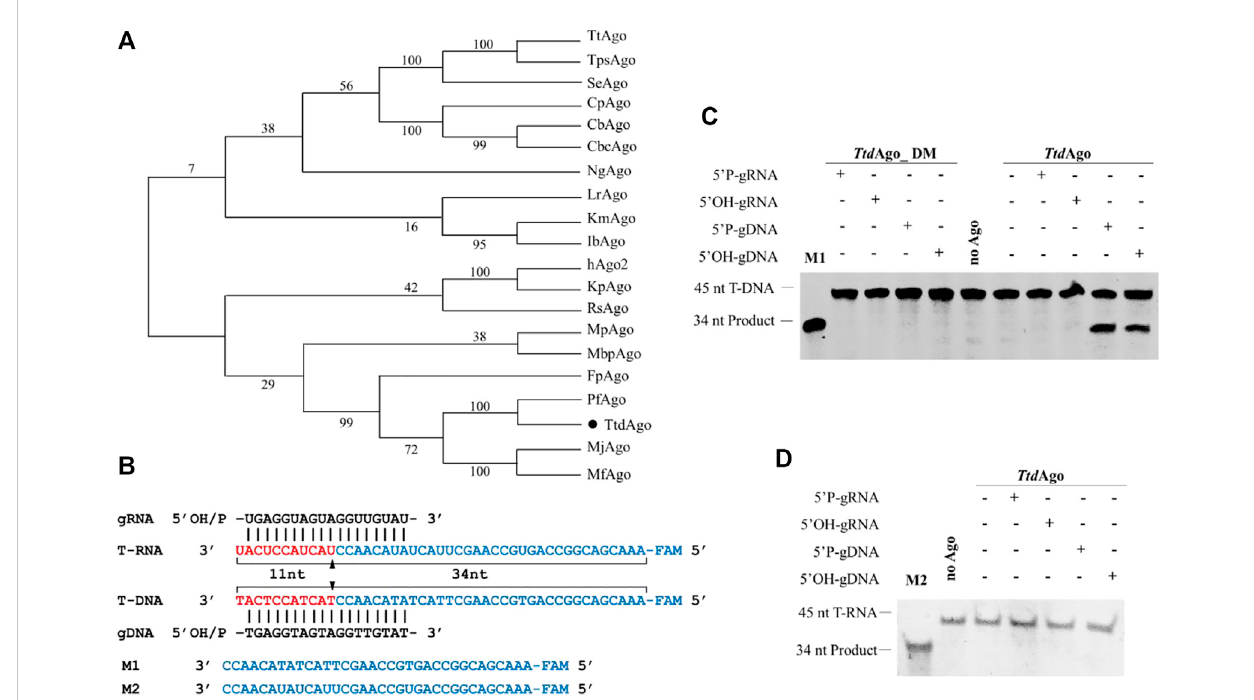
FIGURE 1 Phylogenetic tree analysis and single-stranded nucleic acid cleavage assays of Ttd Ago. (A) Maximum likelihood phylogenetic tree of characterized Agoproteins.Thenumbersatthenodesindicatethebootstrapvaluesformaximumlikelihoodanalysisof1,000resampleddatasets. (B) Sequencesofthe synthetic let7 miRNA-based guide and target sequences (T-DNA and T-RNA) that were used for the in vitro cleavage assays. The black triangles indicate the cleavage site. (C) DNA cleavage activity assay of Ttd Ago. (D) RNA cleavage activity assay of Ttd Ago. Positions of the cleavage products are indicatedontheleftofthegels. Ttd Ago,guide,andtargetweremixedatamolarratioof4:4:1(800 nM Ttd Agopreloadedwith800 nMguide,plus200 nM target) and incubated for 30 min at 75 ° C. Catalytic dead mutant Ttd Ago DM (DM) was used as the control. Lanes M1 and M2 contain chemically synthesized34-ntDNAandRNAcorrespondingtothecleavageproductsofT-DNAandT-RNA,respectively.Allreactionswerecarriedoutinthereaction buffer containing 5 mM Mn 2+